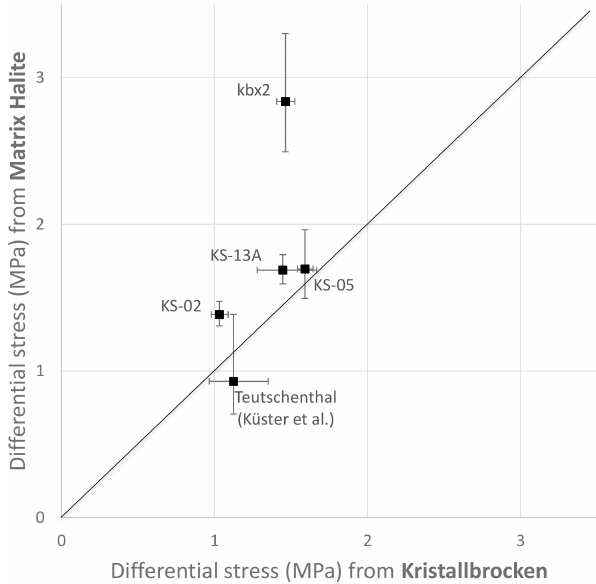
Figure 9. Differential stress vs. strain rate diagram plotting se- lected flow laws at 60 ◦ C. For dislocation creep BGRa KK, Kriechk- lassen 5, 4, and 3 calculated with Eq. (1), A = 2 . 083 × 10 − 6 s − 1 , Q DC = 54kJmol − 1 , and n = 5 (Liu et al., 2017) as well as Av- ery Island samples calculated with Eq. (1), A = 1 . 6 × 10 − 4 s − 1 , Q DC = 68kJmol − 1 , and n = 5 . 3 from Carter et al. (1993) are in- cluded. Dotted lines show combined pressure solution and dislo- cation creep flow laws for different halite grain sizes calculated with Eq. (3); previous values for dislocation creep (Eq. 1); and B = 4 . 7 × 10 − 4 s − 1 , Q PS = 24 . 53kJmol − 1 , and m = 3 (Eq. 2) (Spiers et al., 1990). Results from this study are plotted based on measured median fine-grained halite grain sizes (Fig. 7) and differ- ential stresses from subgrain-size piezometry of Kristallbrocken for each sample (supplement 2 in Barabasch et al., 2022, Table